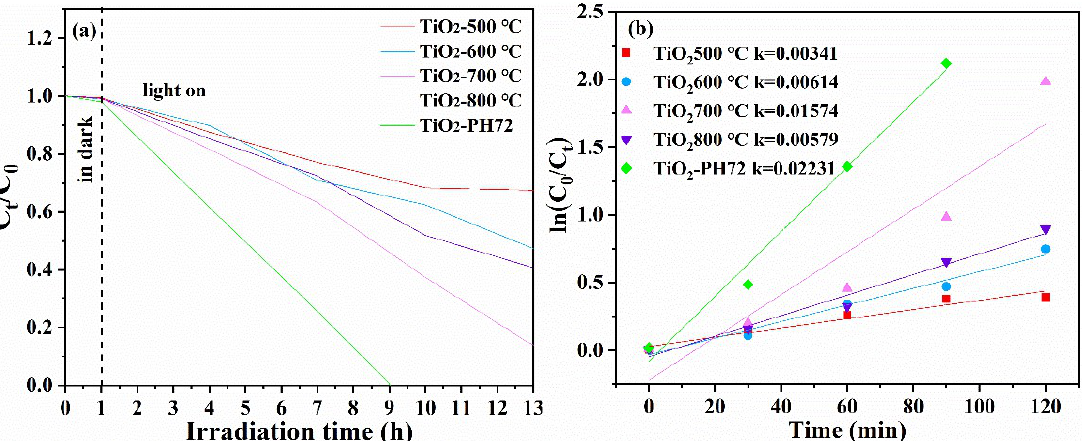
Figure 10. ( a ) Photocatalytic degradation rate of the TiO 2 fibers obtained after calcination at different temperatures and plasma treatments; ( b ) first-order kinetics of photocatalytic degradation.